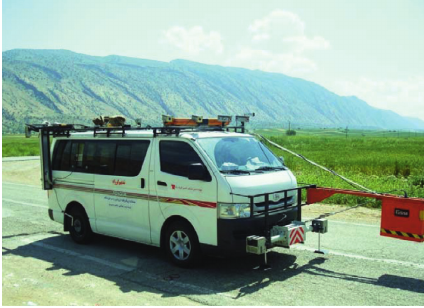
Figure 1: “Tadbirgare Rah” automated